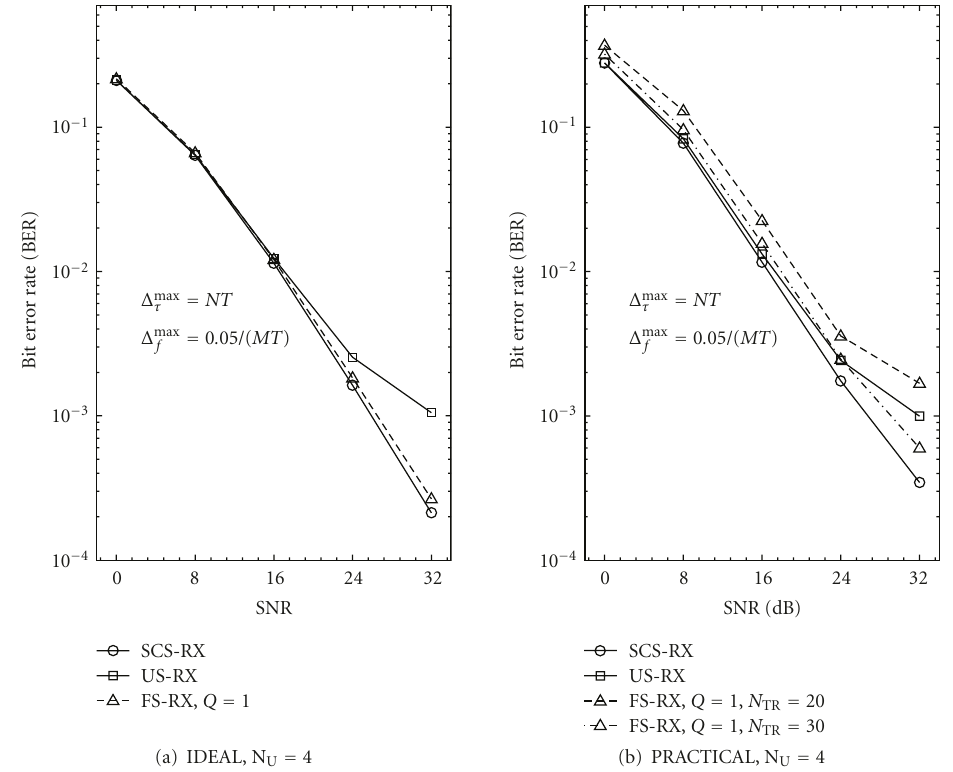
Figure 7: Average BER as a function of the SNR. Ideal and practical performance with 4 users. The training sequence length is equal to 30 symbols. In the right plot, we report also the case with 20 symbols for the FS-RX.